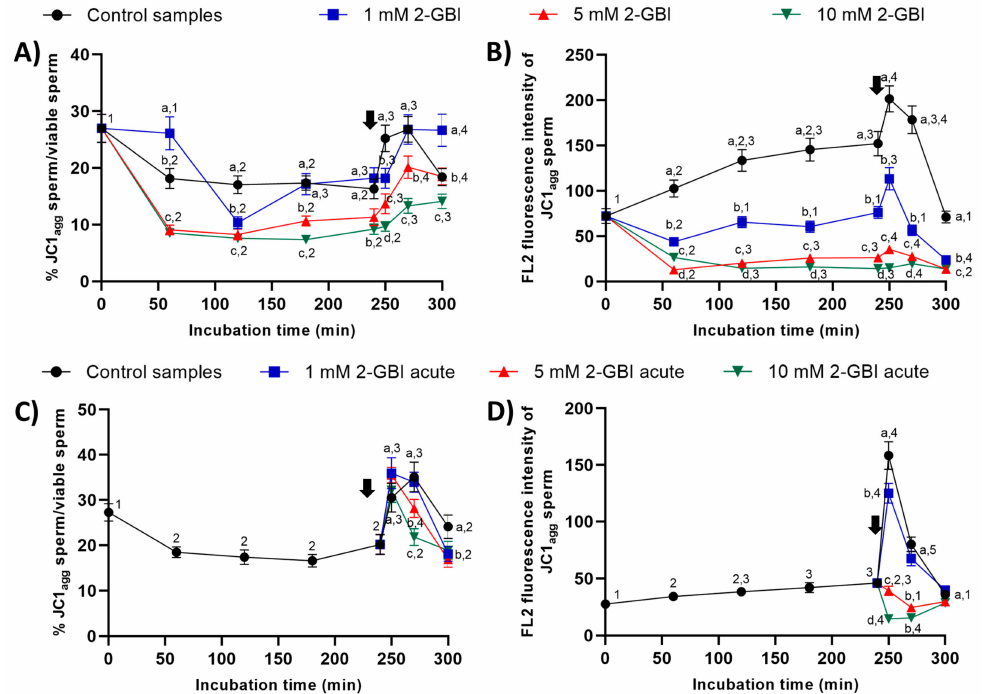
Figure 11. Percentages of sperm with high mitochondrial membrane potential (JC1 agg ), and orange (FL2) fluorescence intensity of JC1 agg in sperm with high mitochondrial membrane potential throughout incubation in capacitating medium (control samples) or capacitating medium plus 1 mM, 5 mM or 10 mM 2-GBI. 2-GBI blocker was added either at 0 min in experiment 1 ( A , B ) or after 240 min of incubation in experiment 2 ( C , D ; acute). Di ff erent superscript letters (a–d) indicate significant di ff erences ( p < 0.05) between samples within the same time point, and di ff erent superscript numbers (1–5) indicate significant di ff erences ( p < 0.05) between time points within a given treatment. Results are expressed as mean ± SEM ( n = 10). The arrow indicates the time at which 10 µ g / mL of progesterone was added to all samples (i.e., 240 min of